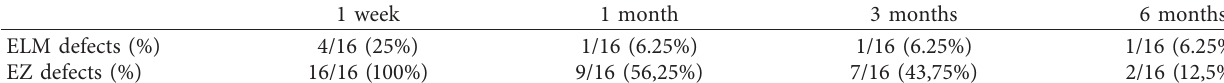
Table 3: Outer retinal layer characteristics at different follow-ups.